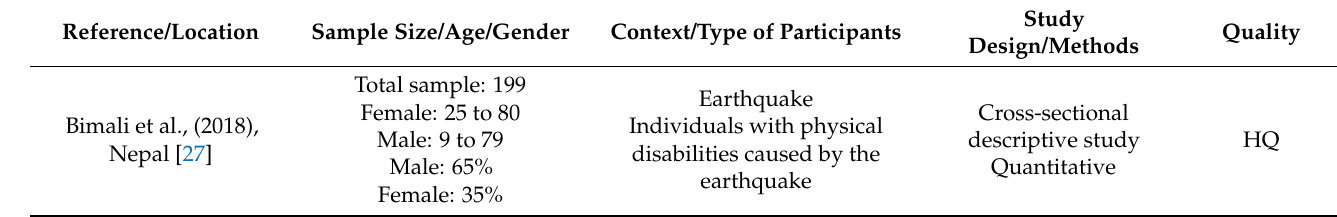
Table 2. Characteristics of selected